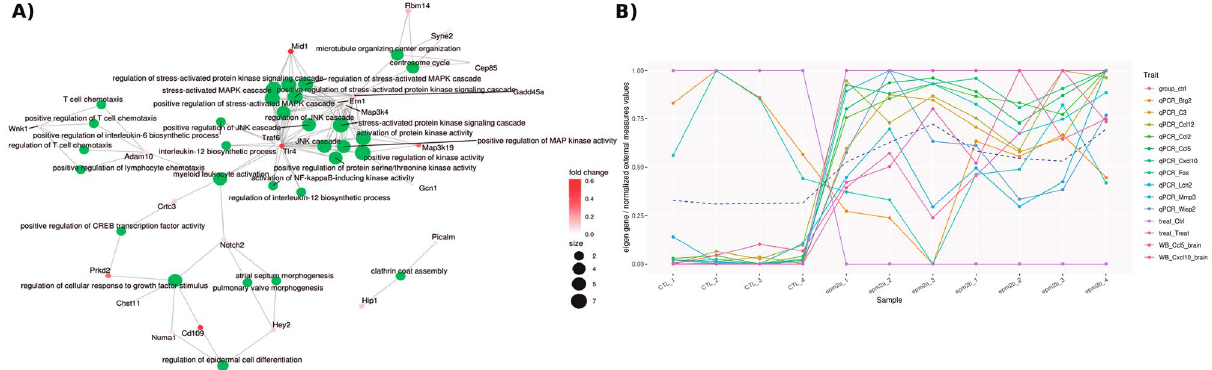
Figure 7. Example plots taken from the Lafora disease study report. ( A ) Functional enrichment plot for GO Biological Processes overrepresented among genes in co-expression module 23. ( B ) Eigen-gene values for module 1, which represent averaged expression values for the genes within the module, as described in “Materials and methods” section, alongside external measure values for all significantly correlated categorical and continuous vectors significantly correlated with the eigen-values (p-value < 0.05), calculated as described in “Materials and methods”